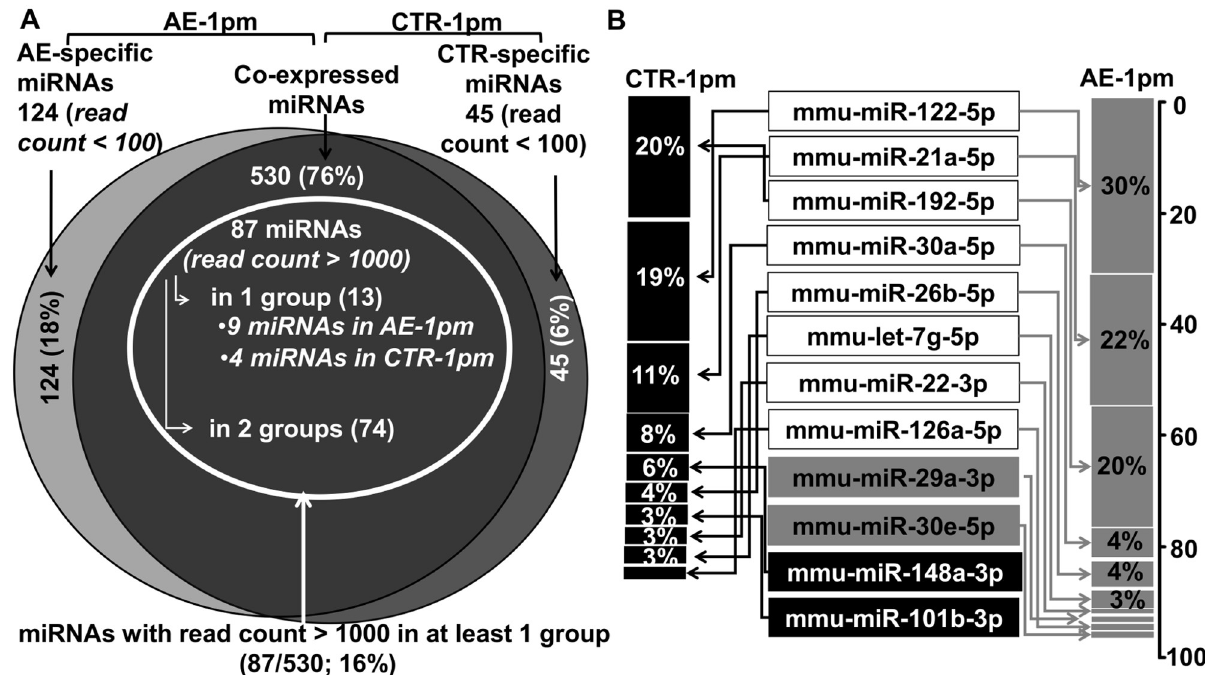
Fig 1. miRNA expression profile in livers of AE-infected and uninfected mice. (A) Venn diagram showing the overlap of expressed miRNA in liver- tissue samples from AE- infected and uninfected animals. (B) Top 10 most abundant miRNA and their frequency (%) in both groups. The two miRNAs in gray rectangles were present only among the top 10 expressed hepatic miRNAs in AE- infected mice, whereas miRNAs in black rectangles were only among the top 10 expressed hepatic miRNAs in uninfected control mice.